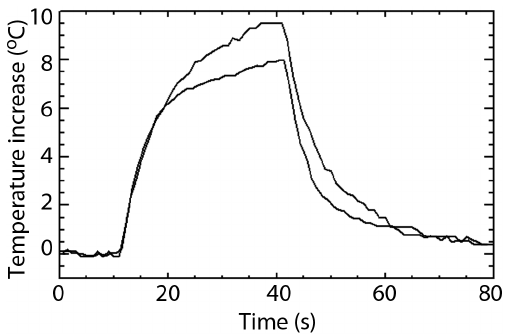
Figure 4. Temperature profiles measured for a calibration filter with fullerene soot (lower curve), and a sample filter with dust and black carbon (upper curve). The curves are nearly identical until 20s (10s of heating) after which they diverge. The continued more rapid in- crease in temperature of the dust – black carbon mixture is thought to be due to the dust.